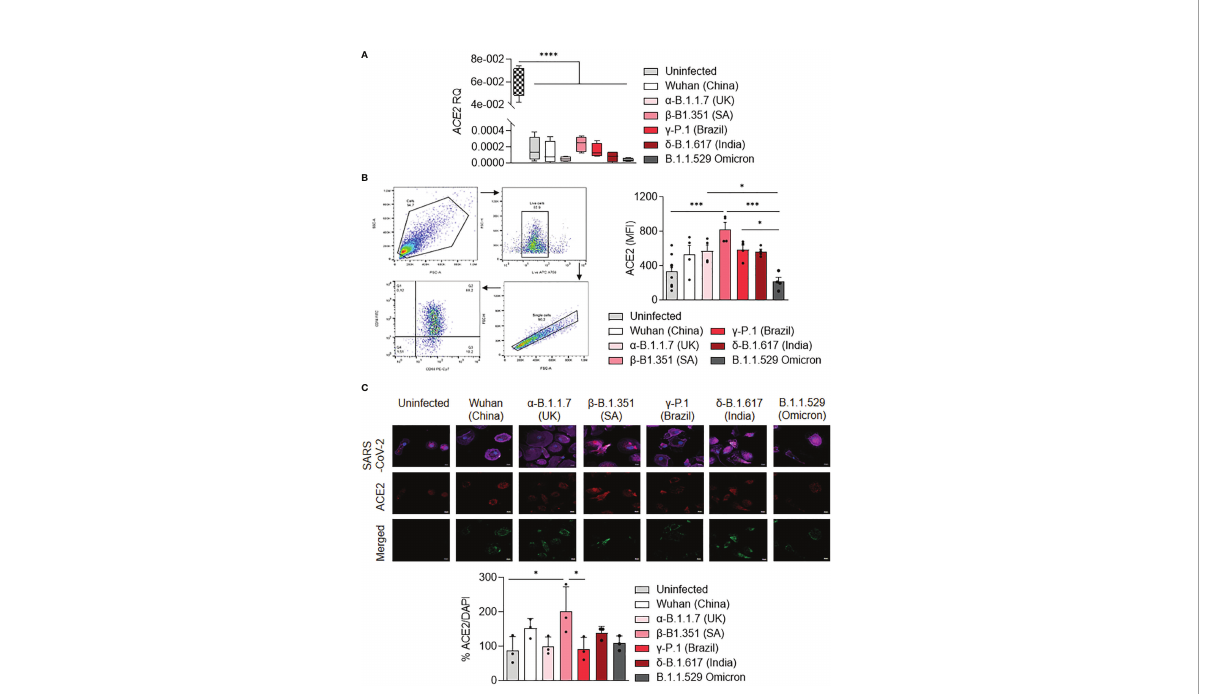
FIGURE 4 ACE2 expression by MDM infected with SARS-CoV-2 variants. MDMs were infected with SARS-CoV-2 variants including Wuhan (China), a -B.1.1.7 (United Kingdom, UK), b -B.1.351 (South Africa, SA), g -P.1 (Brazil), d -B.1.617 (India) and B.1.1.529 (Omicron) (0.1 MOI). (A) Relative quantity of ACE2 gene was evaluated by q-RTPCR at 6 hours post-infection after normalization with housekeeping ACTB gene as endogenous control. Data values represent the mean ± SD from 4 healthy donors, and the experiments on unstimulated Vero E6 cells were performed in triplicate. (B) ACE2 protein expression was quanti fi ed by fl ow cytometry in MDMs at 24 hours post-infection and expressed as mean fl uorescence intensity (MFI) values. (C) ACE2 was evaluated by immuno fl uorescence in MDMs at 24 hours post-infection. ACE2 was identi fi ed in red, SARS-CoV-2 in green, F-actin in purple and DAPI. Relative ACE2 expression was quanti fi ed by fl uorescence with ImageJ software. Statistical analysis was performed with two-way ANOVA and Tukey ’ s multiple comparison test. * p ≤ 0.05, *** p ≤ 0.001 and **** p ≤ 0.0001